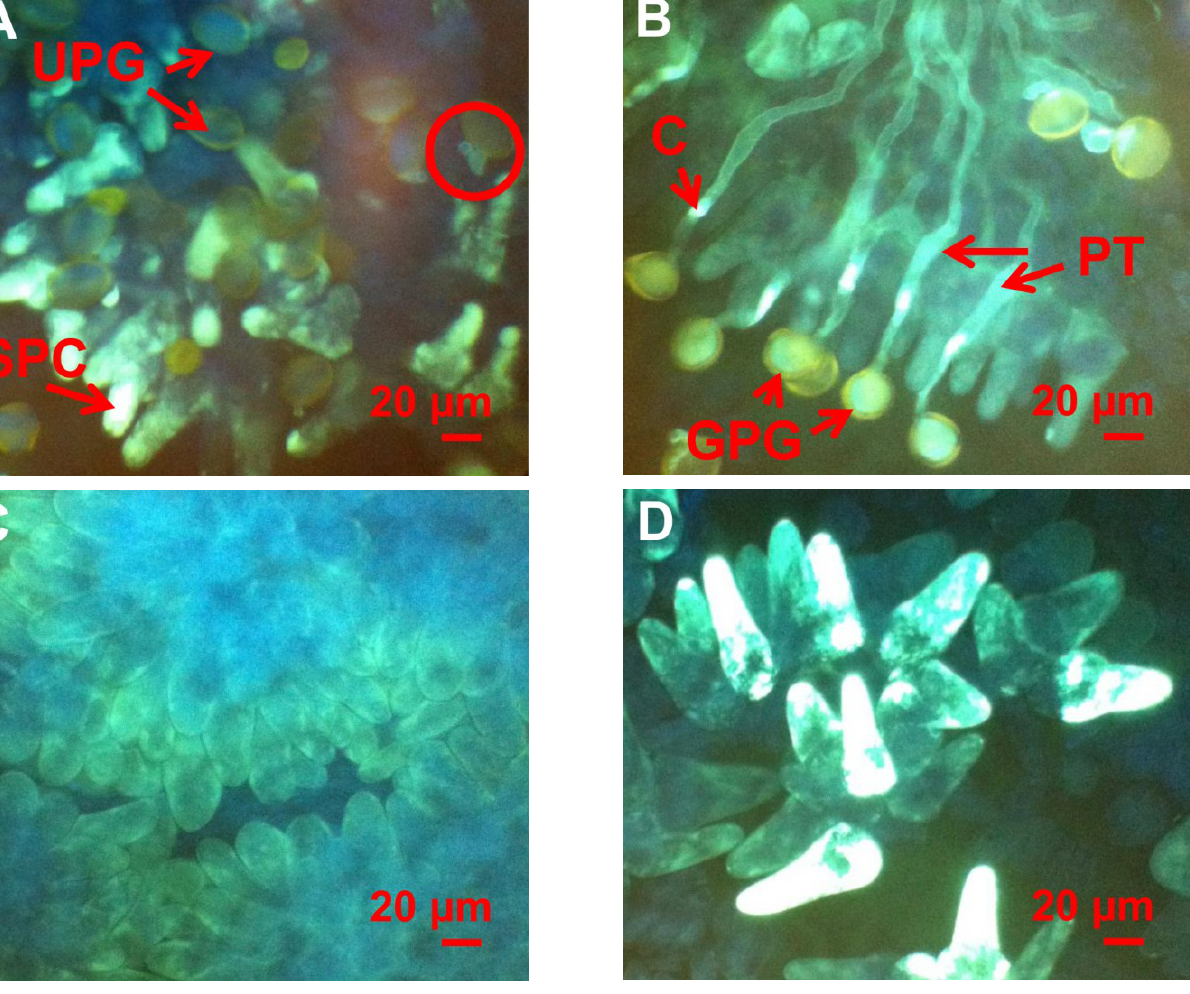
F IGURE 2. Fluorescence microscopy images of Brassica rapa stigmas (375 × magnification). (A) Ungerminated pollen grains (UPG), stained papilla cells (SPC) and a germinated pollen grain with a pollen tube that has not penetrated the stigma (circled in red). (B) Germinated pollen grains (GPG) with pollen tubes (PT) that have penetrated the stigma, and a callose deposit within a pollen tube (C). (C) Papilla cells on a virgin stigma. (D) Stained papilla cells after contact with